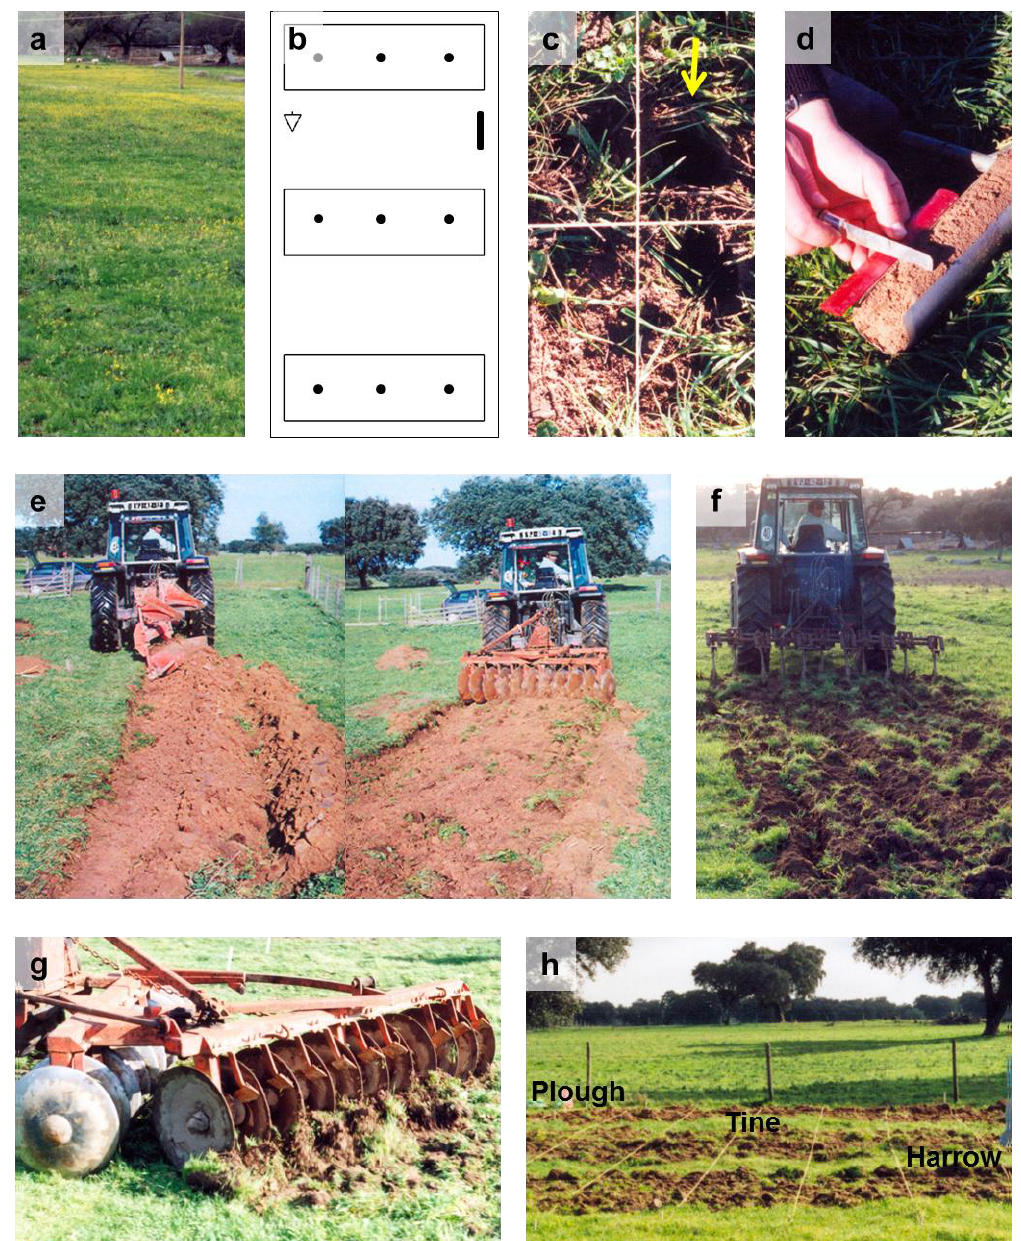
Figure 6. ( a ) General view of area of study; ( b ) Experimental scheme showing plots (top down, plough, tine, harrow), location of sampled cores, direction of slope (arrow), with black vertical bar representing 1 m; ( c ) Orthogonal grid with sample location (arrow); ( d ) Soil core measurement; ( e ) Plough; ( f ) Tine; ( g ) Harrow; ( h ) General view with location of plots after